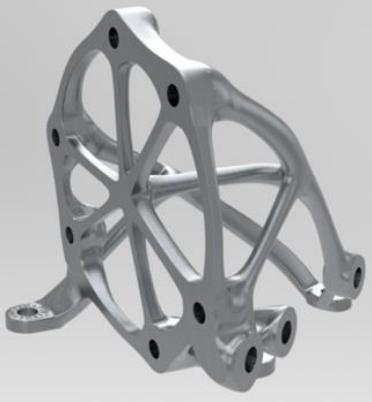
Figure 8. Final Optimization design.